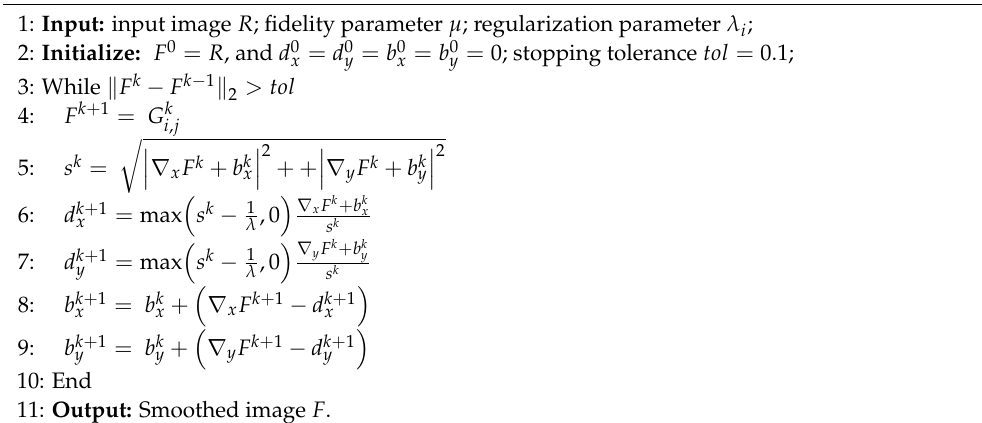
Algorithm 2: The ITVM Solution Based on Split Bregman Algorithm for Smoothing